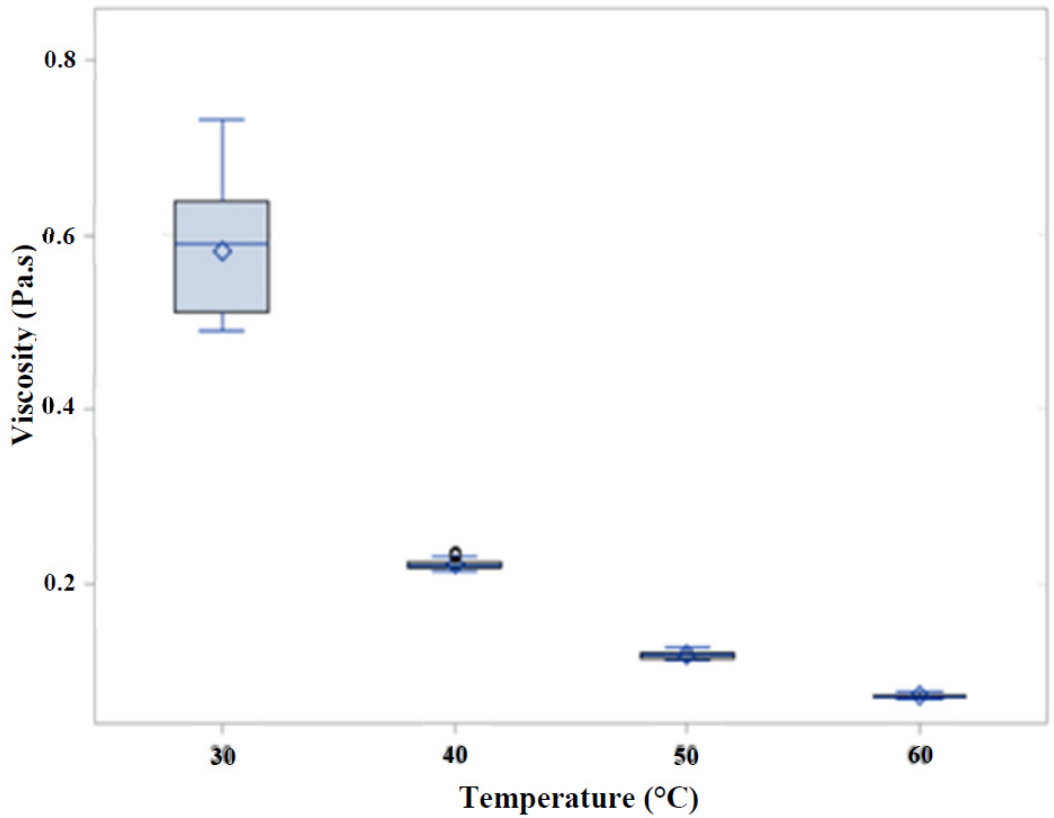
Figure 3. Impact of temperature on the viscosity distribution profile of CTO.